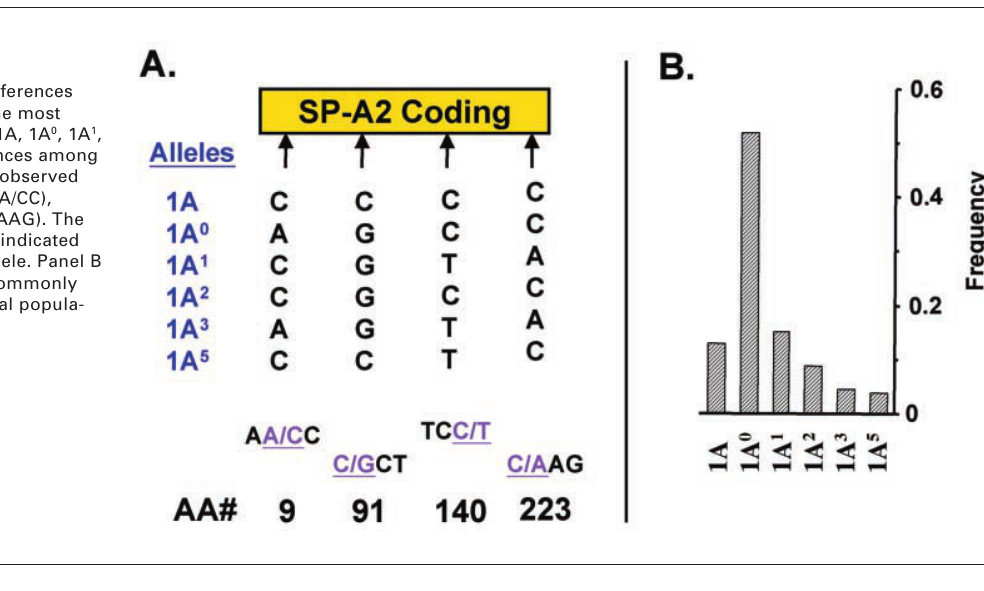
Human SP-A 5 ′ UTR and splice variants. There are several 5 ′ untranslated exons (A, B/B ′ , C ′ /C, and D/D ′ ) in both SP-A1 and SP-A2. These exons splice in different configurations specific for SP-A2 (ABD and ABD ′ : major transcripts) and for SP-A1 (AD ′ : major transcript; ACD ′ and AB ′ D ′ minor transcripts). The translation start site (TGA) is noted. The arrows in exon A denote different transcription start sites [17]. Not drawn to